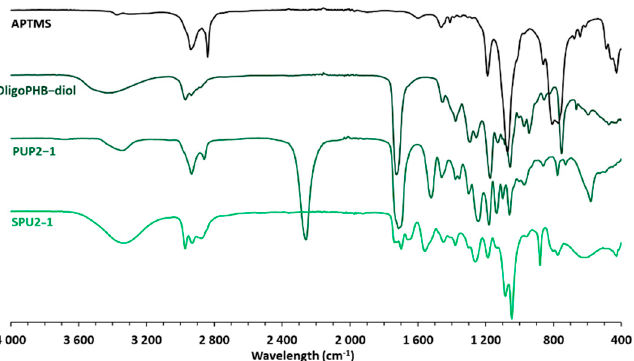
Figure 2. FTIR spectra of the synthetic route (from top to bottom), from APTMS and oligoPHB-diol to SPU polymer, for